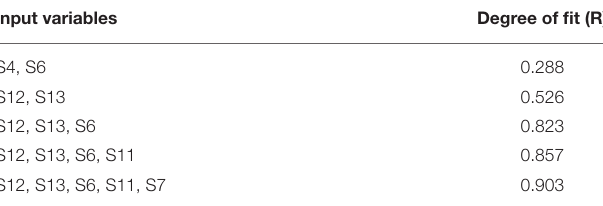
TABLE 4 | Regression with S5 as the output